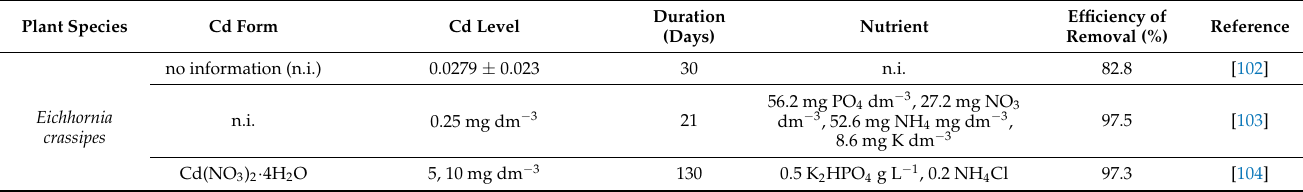
Table 14. Cadmium efficiency of removal of various